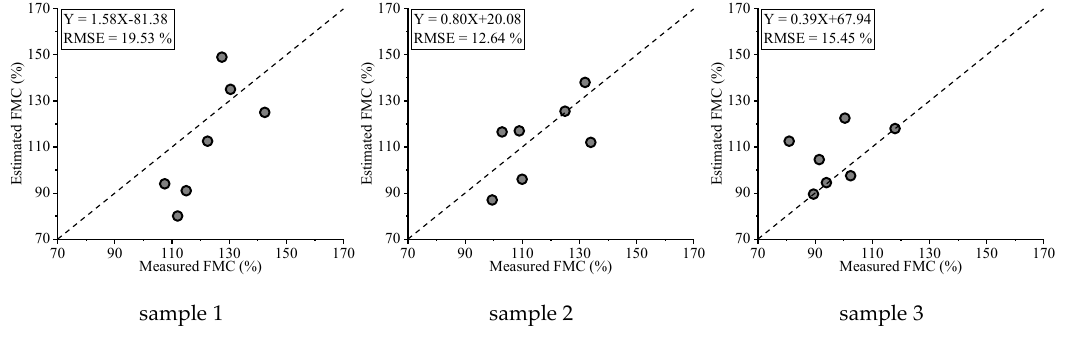
Figure 9. Scatterplots between modelled and measured VH backscatters.